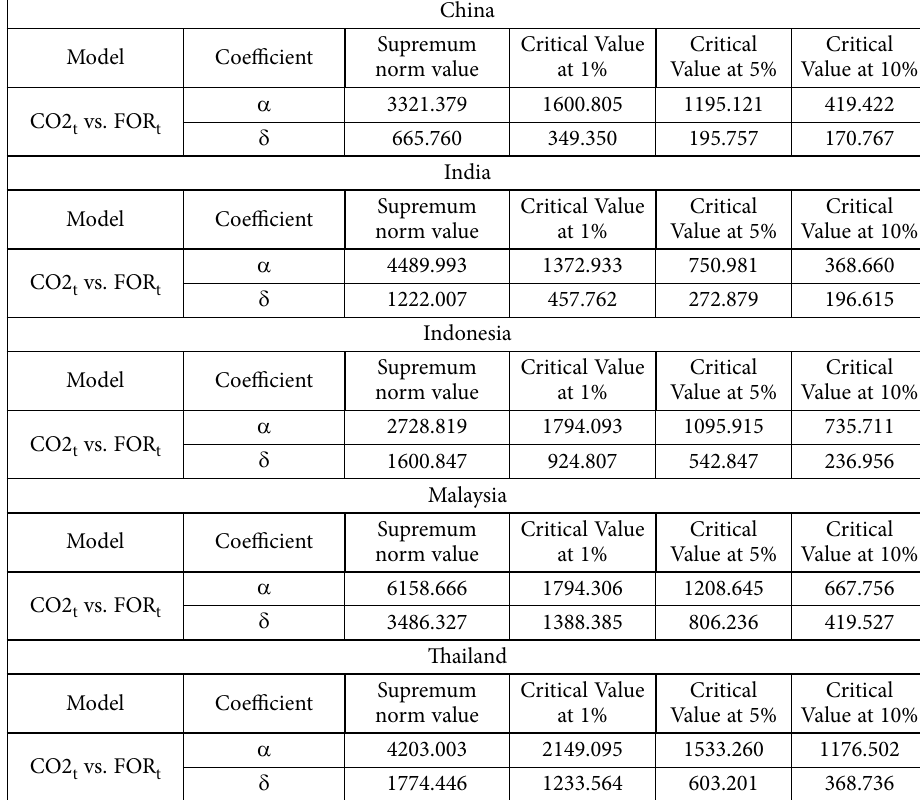
Table 3. Results of quantile cointegration test